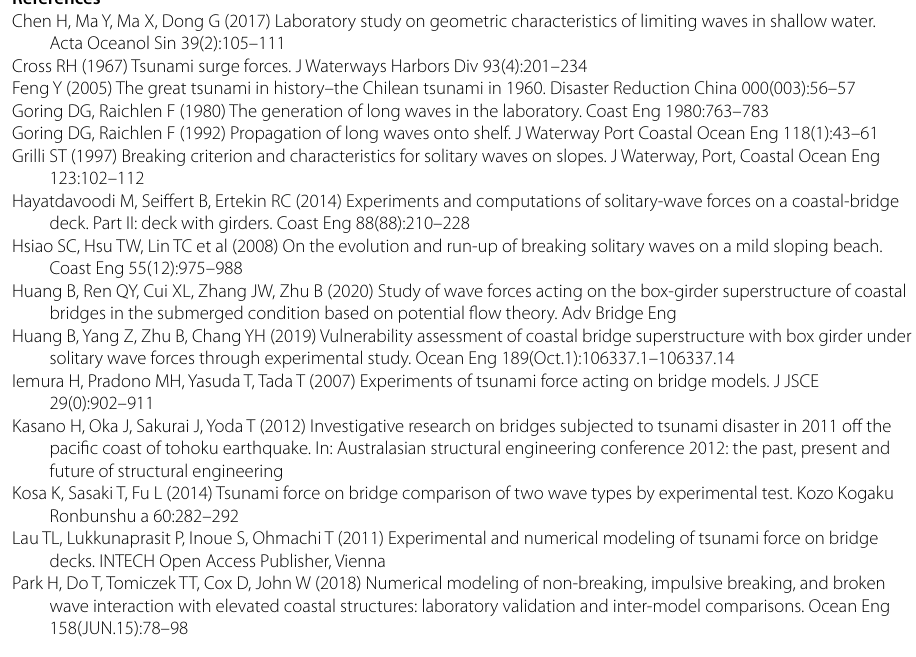
Hui Li: Figure drawing. Ning Wang: Methodology, Funding secure, Supervision. The author(s) read and approved the final manuscript. Funding National Natural Science Foundation of China (Grant no. 51678491), Science and Technology Planning Project of Sichuan Province (Grant No. 2021JDTD0012). Availability of data and materials No objection for data